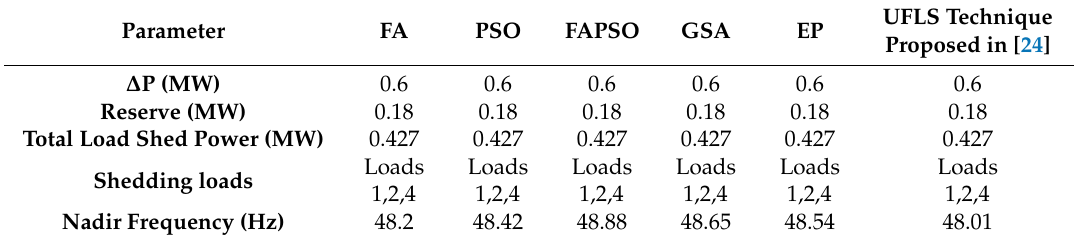
Table 10. The UFLS parameters for load increment of 0.9 MW after islanding.